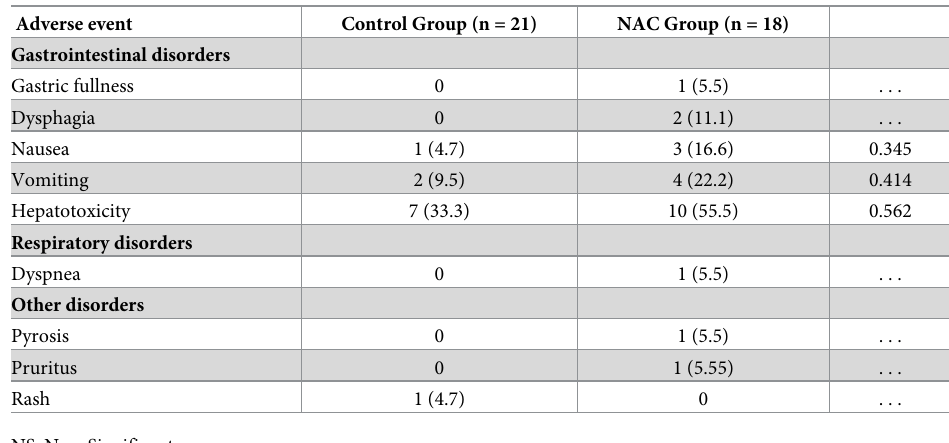
Table 2. Major adverse events seen in both groups.